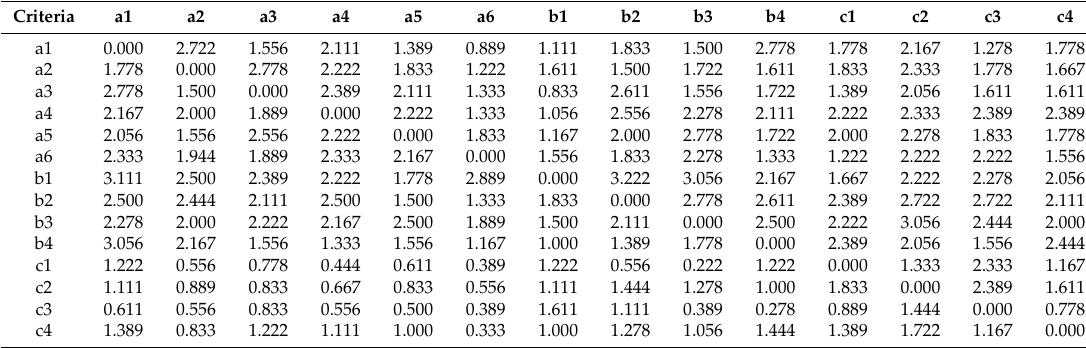
Table 7. Group consensus of the 18 respondents on the degree of influence among the criteria. Criteria